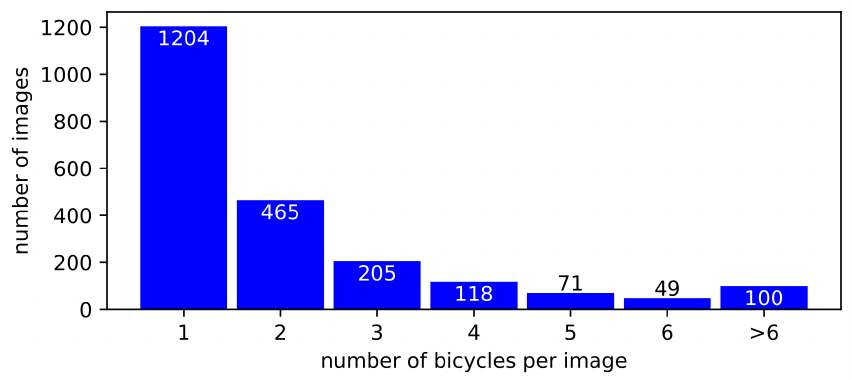
Figure 1. This histogram shows the numbers of images in the Dresden subset of the YFCC100m dataset containing between one and six, and more than six